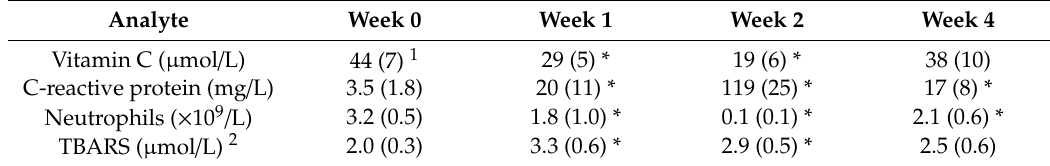
Figure 3. C-reactive protein concentrations in the patients. The C-reactive protein concentrations were assessed relative to ( a ) time of sampling, and ( b ) vitamin C concentration ( < or > 50 µ mol / L, i.e., adequate). Box plots show median with 25th and 75th percentiles as boundaries, and whiskers are the 10th and 90th percentiles, with symbols indicating outlying data points. The mean values of weeks 1, 2, and 4 were significantly higher than baseline ( p < 0.01); < 50 µ mol / L values were significantly higher than > 50 µ mol / L values ( p < 0.001). Table 2. Vitamin C status relative to febrile neutropenia and oxidative stress.